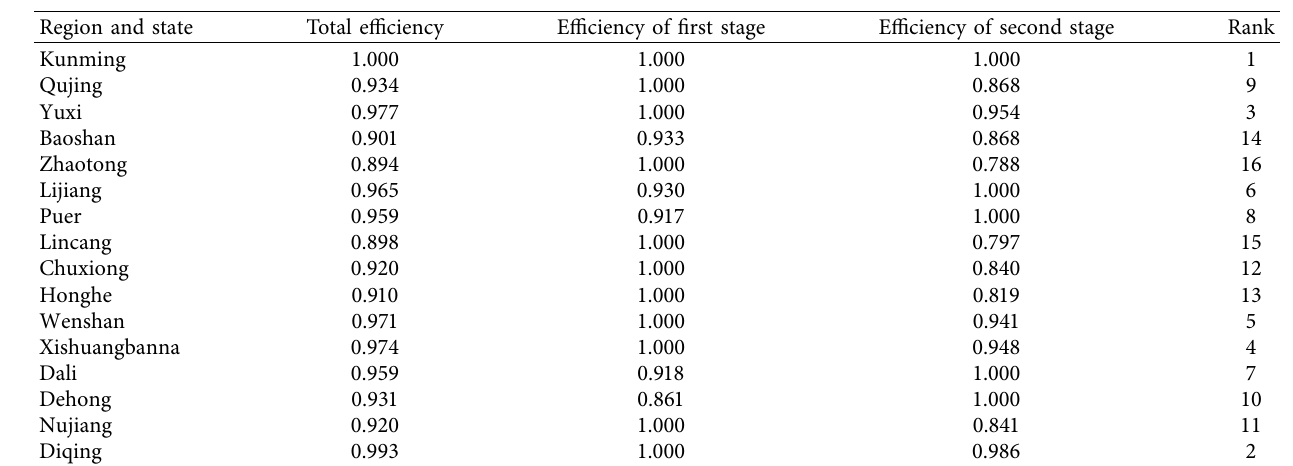
Table 3: Evaluation results.